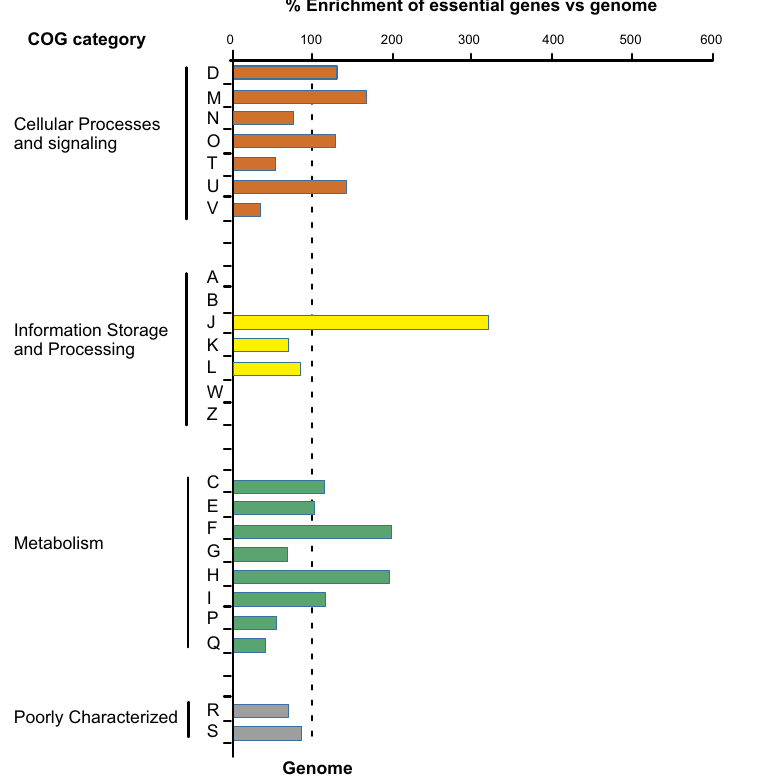
Figure 2. Functional class enrichment analysis of essential genes based on Cluster of Orthologous Groups (COG) categories. The subset of genomic genes contributing to each COG category was set to 100%. The percentage of essential genes within a COG category was calculated by comparison to genomic genes. D, cell cycle control, cell division, chromosome partitioning; M, cell wall/ membrane/envelope biogenesis; N, cell motility; O, posttranslational modification, protein turnover, chaperones; T, signal transduction mechanisms; U, intracellular trafficking, secretion, and vesicular transport; V, defense mechanisms; J, Translation, ribosomal structure and biogenesis; K, Transcription; L, Replication, recombination and repair; C, energy production and conversion; E, amino acid transport and metabolism; F, nucleotide transport and metabolism; G, carbohydrate transport and metabolism; H, coenzyme transport and metabolism; I, lipid transport and metabolism; P, inorganic ion transport and metabolism; Q, secondary metabolites biosynthesis, transport and catabolism; R, general function prediction only; S, function unknown.